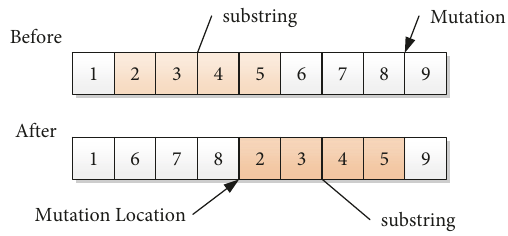
Figure 3: Example diagram of slight